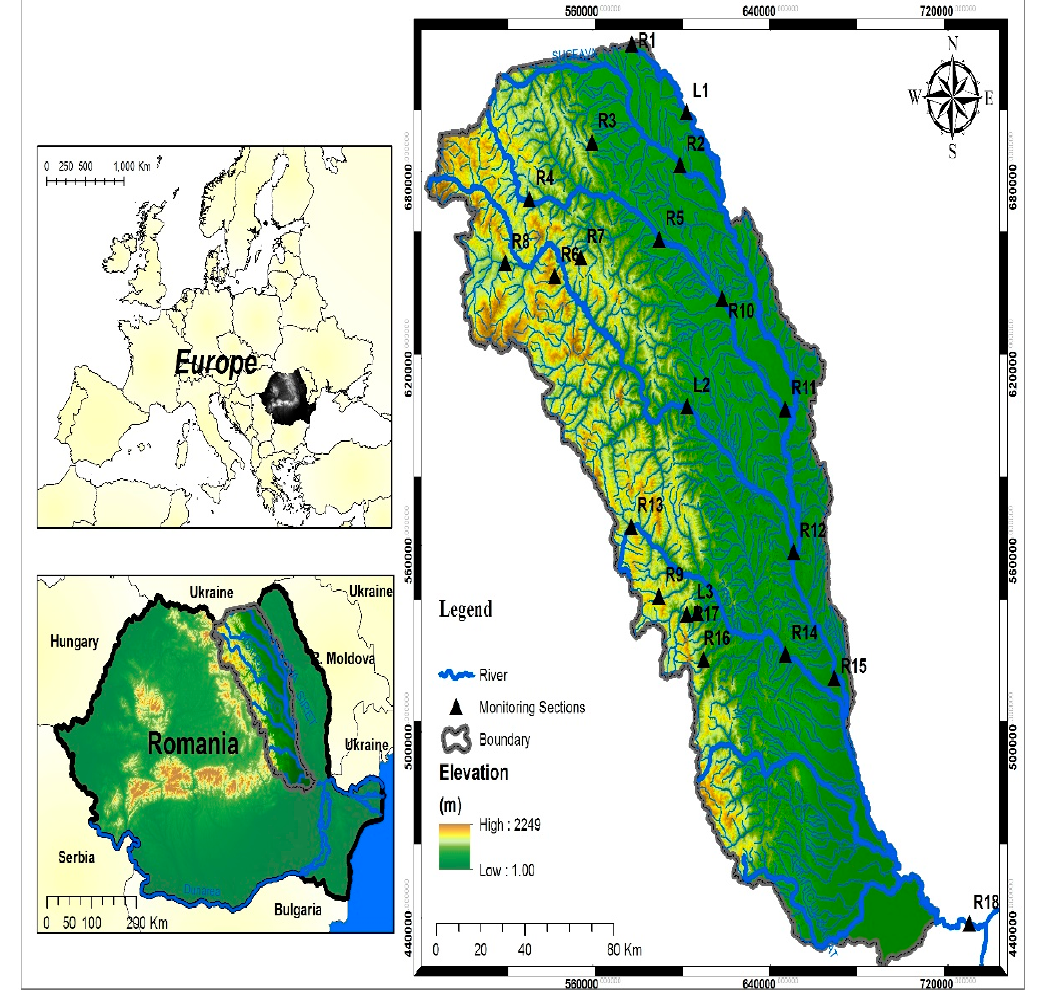
Figure 1. Study area and sampling points in the Siret River